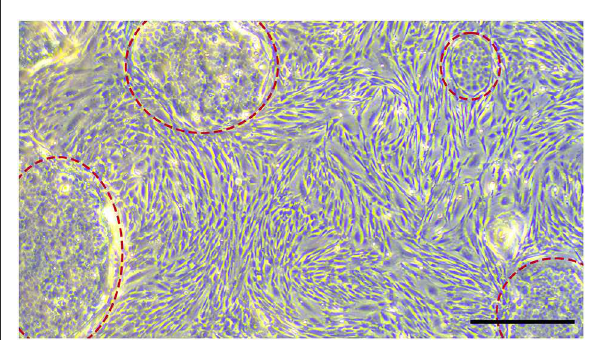
FIGURE6 MSCs isolated from the youngest donor (2.5 years) mixed with a subpopulation of cells, which formed cobblestone-like clusters (highlighted with red circles). Scale bar represents 500 µ m.